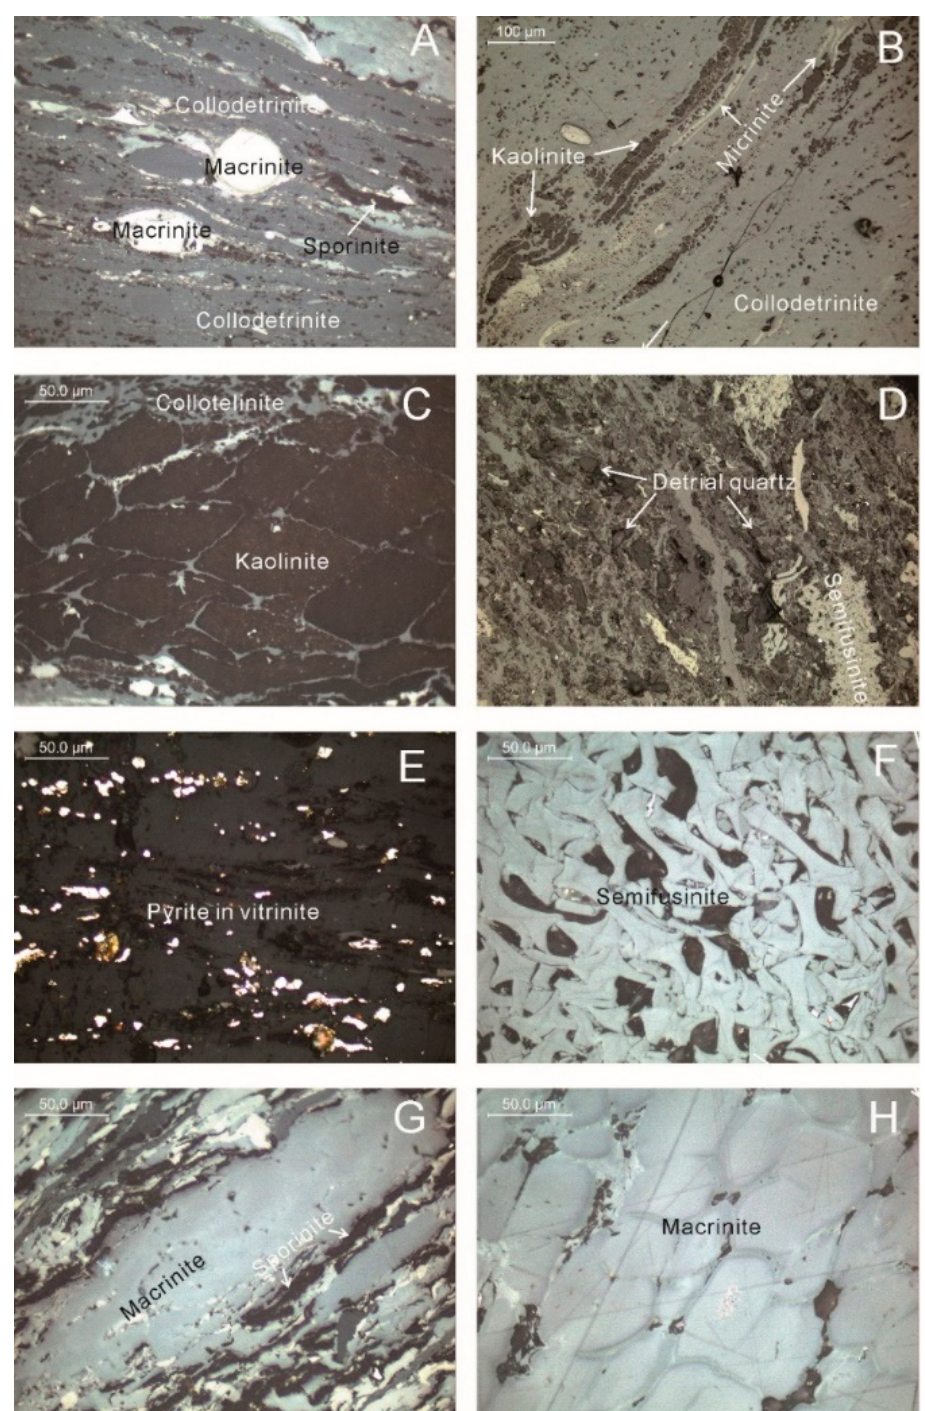
Figure 3. Maceral and minerals in the Upper No.3 coals. ( A ) Collodetrinite, macrinite, and sporinite (LBS3U-13); ( B ) Kaolinite, micrinite in collodetrinite (LBS3U-8); ( C ) Kaolinite in collotelinite (LBS3U-9); ( D ) detrial quartz grains in macerals (LBS3U-4); ( E ) Pyrite in vitrinite (LBS3U-1); ( F ) Semifusinite; ( G ) Macrinite, Sporinite, and colloderitine (LBS3U-3); ( H ) Macrinite (LBS3U-10). ( A , C – H ) is under oil reflectance white light; ( B ) is under white reflectance light.